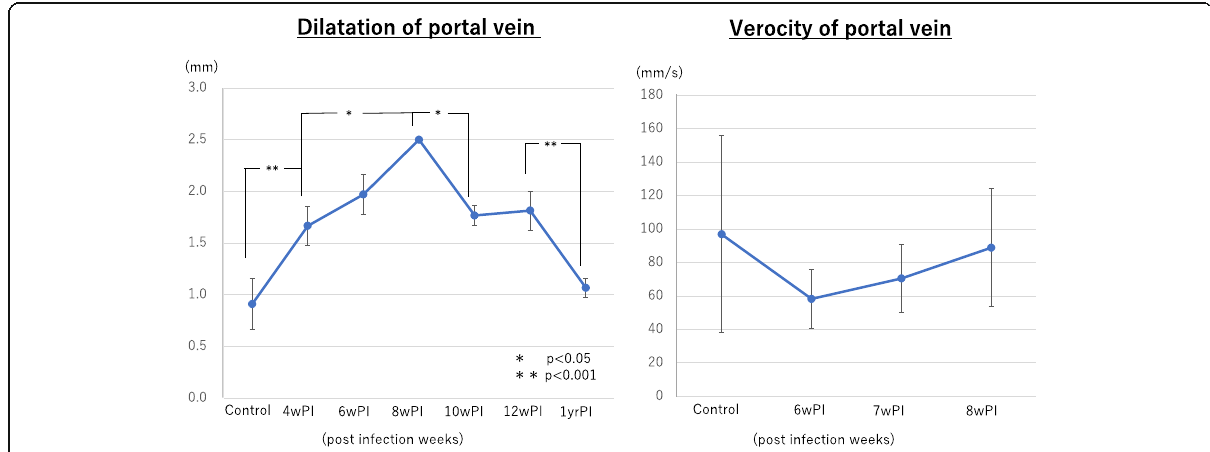
Fig. 5 Dilatation of the portal vein and velocity. The portal vein became enlarged, which continued until 8 weeks PI and then gradually recovered to the normal range. Blood flow of the portal vein temporally slowed down at 6 weeks PI but returned back to the control level